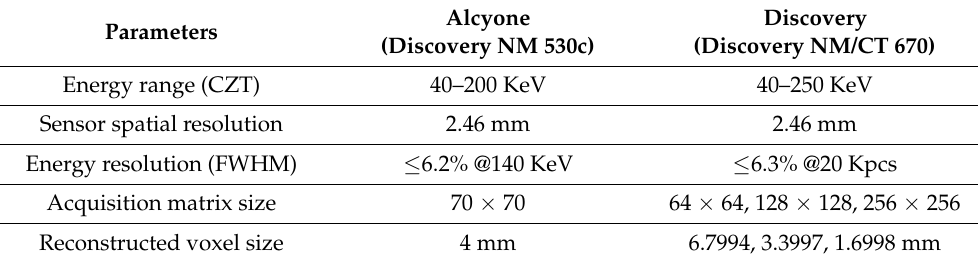
Table 1. Technical characteristics of the two